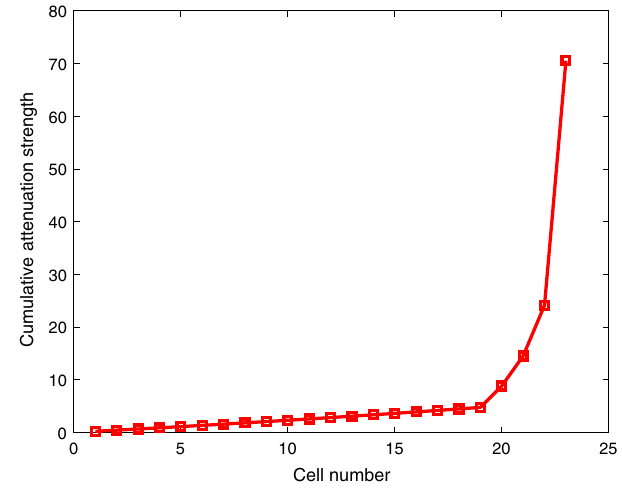
FIG. 9. Cumulative attenuation strength along the linac, which is defined as